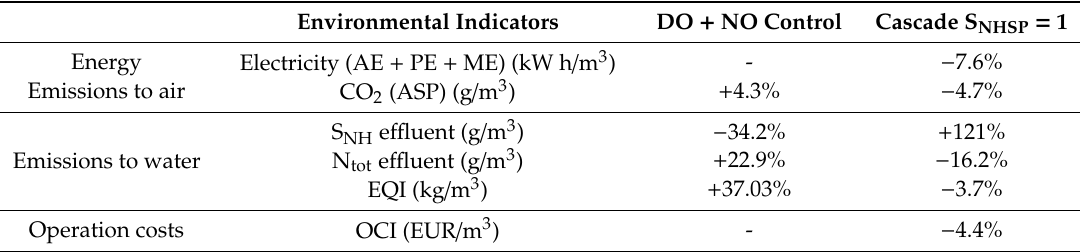
Table 4. Environmental and cost indicators of Cascade S NHSP and DO + NO control relative to default DO control